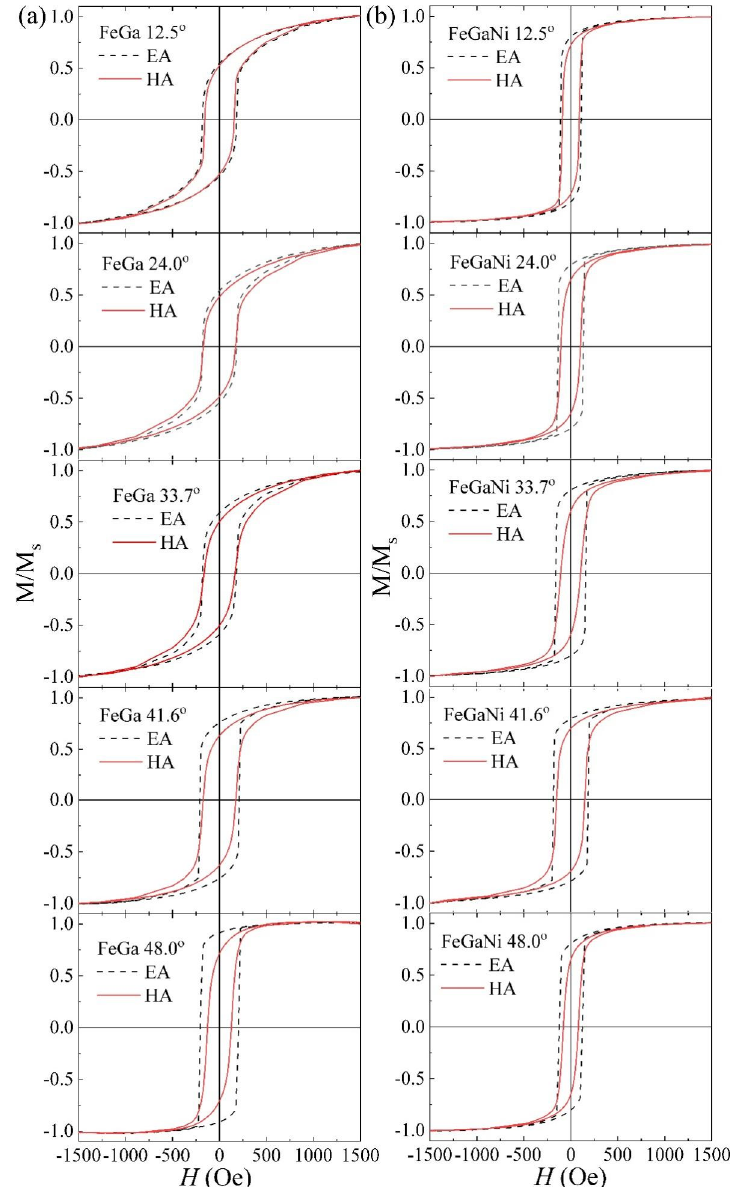
Figure 4. Hysteresis loops of FeGa ( a ) and FeGaNi ( b ) with increase in α .